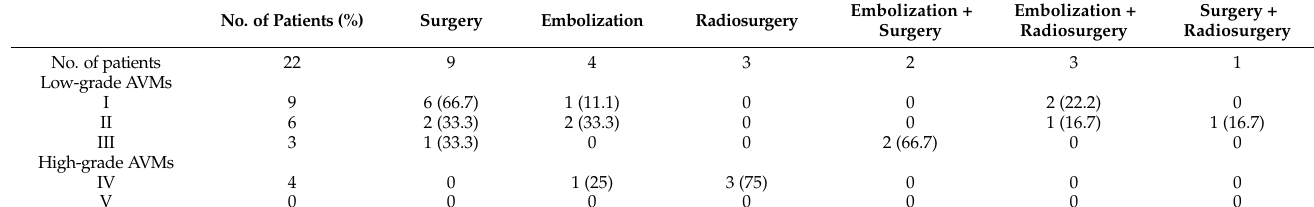
Table 3. Treatment strategy depending on the Spetzler-Martin grade.